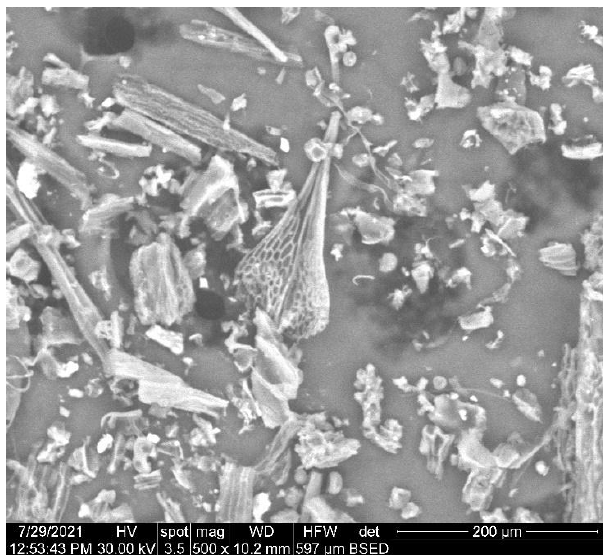
Figure 9. High-resolution SEM images of Artemisia annua .